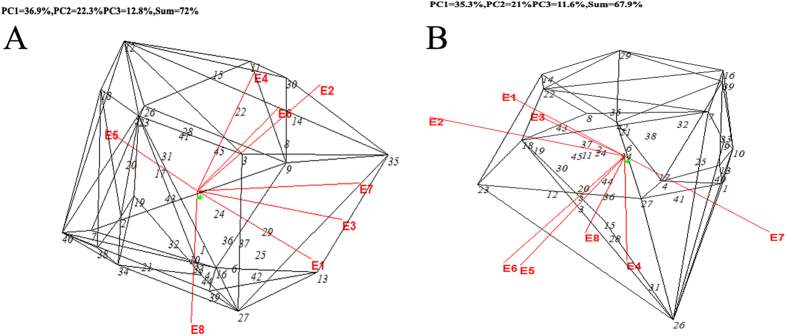
A 3D-GGE biplot analysis.Refer to Fig. 1 for abbreviations.